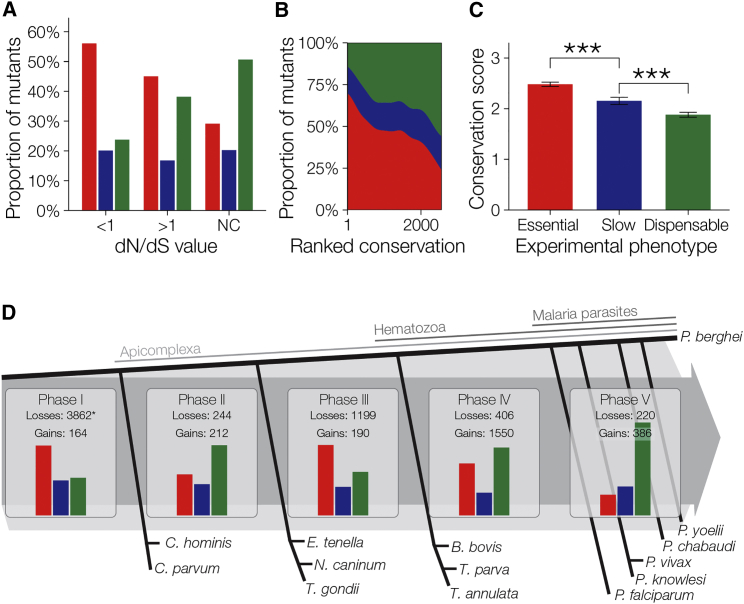
Genomic Reduction and High Gene Essentiality during the Evolution of Hematozoa(A) Phenotype distributions for the P. berghei orthologs of genes under purifying selection in P. falciparum (dN/dS <1) and genes potentially under positive selection in P. falciparum (dN/dS >1) compared to P. berghei genes without orthologs in P. falciparum.(B) Genes highly conserved between Plasmodium species are enriched for essential phenotypes. Genes are ranked by their conservation between P. chabaudi and P. falciparum (according to the MalariaGEN Plasmodium falciparum Community Project, 2016) with the phenotype distribution of P. berghei orthologs and different conservation levels plotted.(C) Phenotype is significantly predictive of inter-species conservation score (∗∗∗p < 0.0001).(D) The evolutionary history of P. berghei is shown through the gain and loss of groups of orthologs as reconstructed using a Dollo parsimony model (∗ taken from Woo et al. [2015]). Bar charts show relative distribution of P. berghei phenotypes among extant genes belonging to the orthologous groups gained during each phase: Phase I, from the free-living protoapicomplexan to the first apicomplexan; Phase II, from the first apicomplexan to the ancestor of the piroplasms and coccidians; Phase III, from this ancestor to the first hematozoan; Phase IV, from the first hematozoan to the first malaria parasite; and Phase V, from the first malaria parasite to P. berghei.See also Table S6.